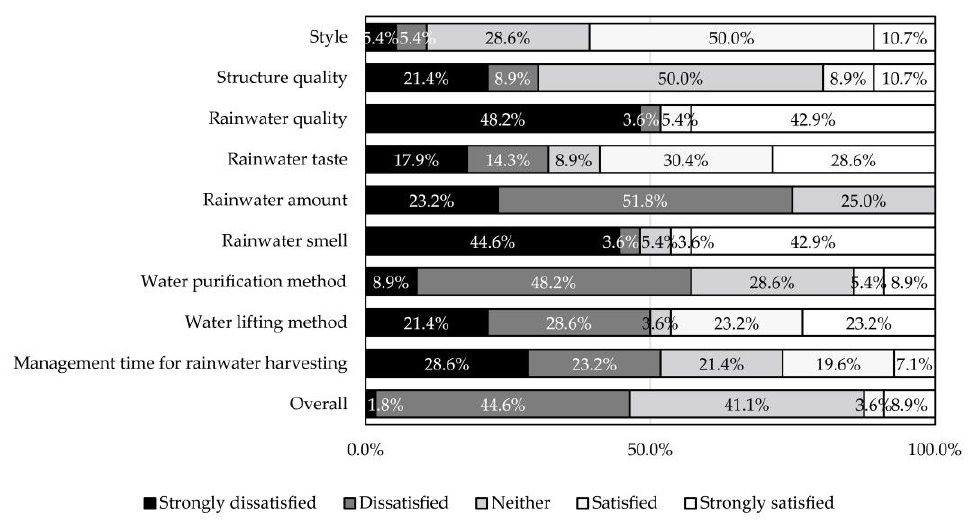
Figure 4. Satisfaction evaluation of everyday use ( n =